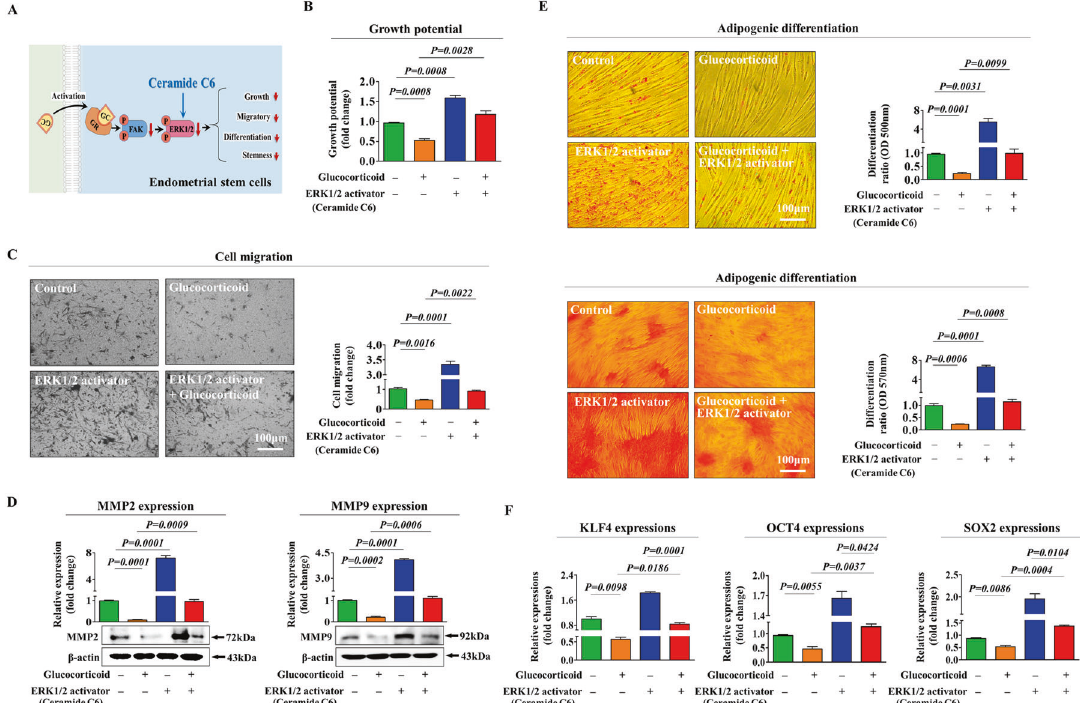
Fig. 6 Activation of the ERK1/2 signaling pathway attenuates glucocorticoid-induced inhibitory effects on various stem cell functions. A schematic diagram regarding the functional role of the FAK/ERK1/2 signaling pathway in mediating glucocorticoid-induced effects is shown ( A ). Endometrial stem cells were pretreated with the ERK1/2 activator ceramide C6 (10 µM) for 1 h prior to treatment with 500 nM glucocorticoid for 48 h, and the subsequent glucocorticoid-induced changes in cell proliferation were analyzed by MTT assays.